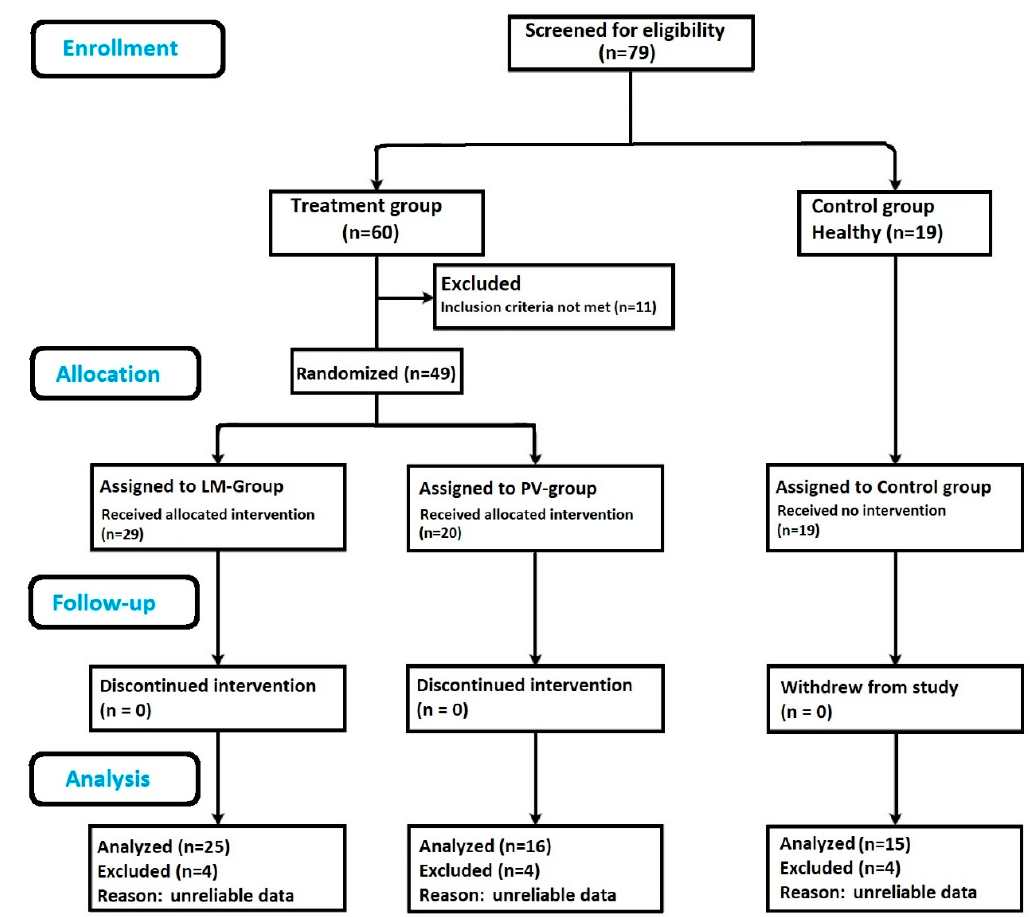
Figure 1. Flow chart showing study outline: subject enrollment, randomization, follow up and sample size analyzed. Lumega-Z (LM), PreserVision (PV).